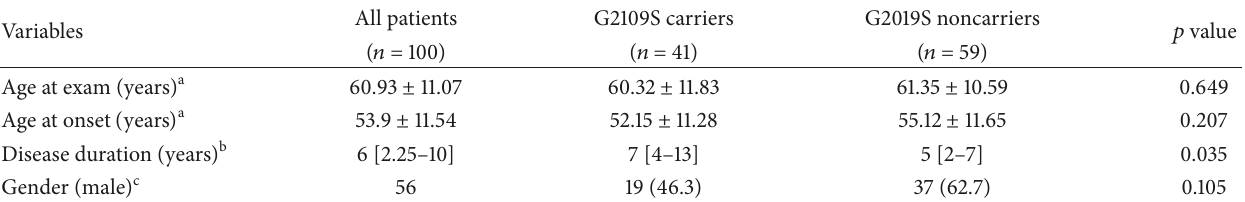
Table 1: Demographic features of LRRK2 G2019S carrier and noncarrier patients.